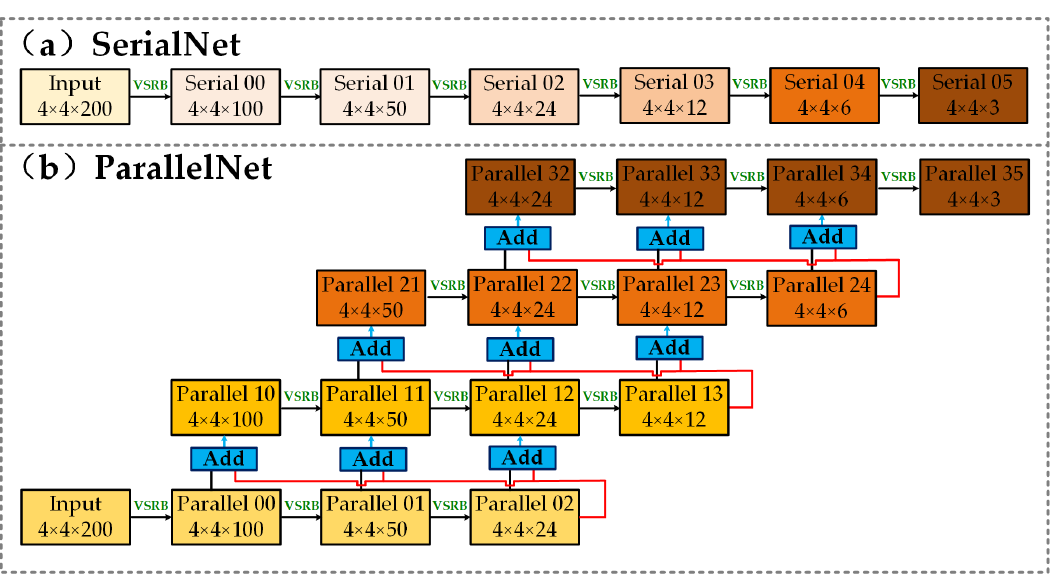
Figure 8. SerialNet and ParallelNet. VSRB represents the variable spectral residual